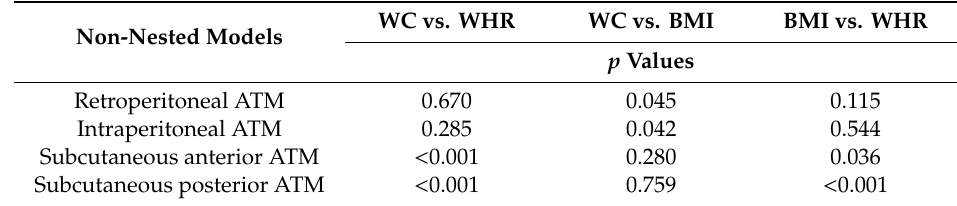
Figure 1. Sites of ectopic fat deposition [29]. Table 5. Comparing the predictive value of waist circumference, waist-to-hip ratio, and body mass index for individual adipose tissue compartments [28].